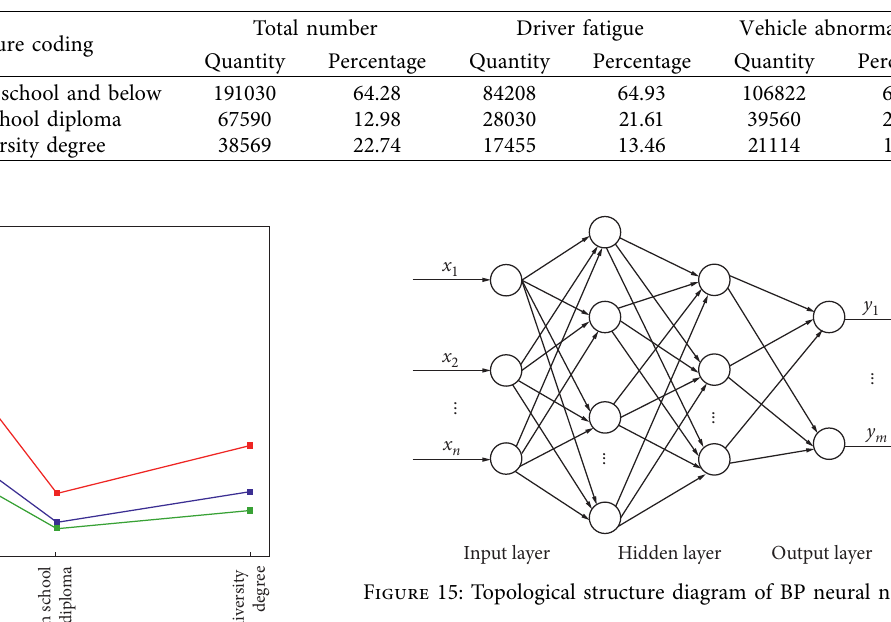
Figure 13: Distribution of forewarning types corresponding to drivers of different genders. Table 9: Distribution of forewarning types of buses for drivers with different degree.